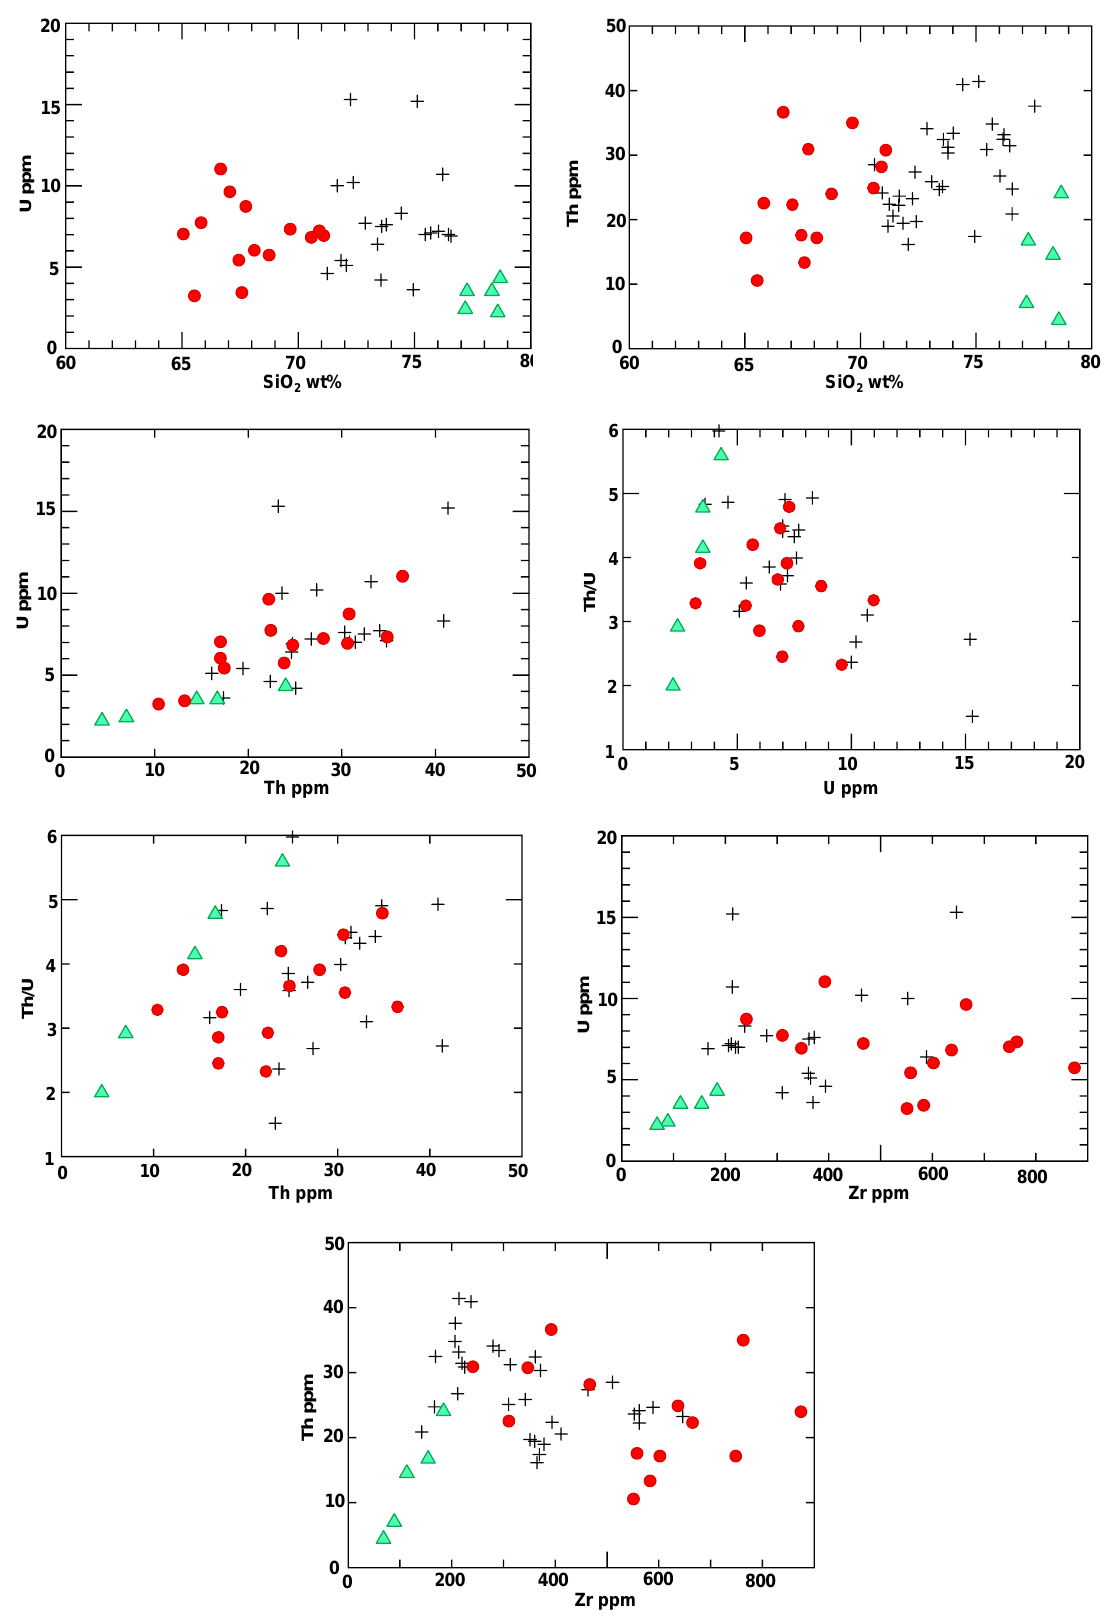
Figure 2. Radioactive element plots for ground gamma ray spectrometry measurements of syenogranite, alkali feldspar granite and quartz syenite at Nikeiba, Southeastern Desert, Egypt. Symbols are the same in the following diagrams ( + syenogranite, alkali feldspar granite and quartz syenite); diagram axes indicate data plots in logarithmic scale. ( a ) eTh (ppm) vs. K %; ( b ) eU (ppm) vs. eTh (ppm); ( c ) eU/eTh ratio vs. eTh (ppm); ( d ) eU/eTh ratio vs. eU (ppm); ( e ) eU-(eTh/3.5) vs. eU (ppm) binary diagrams.